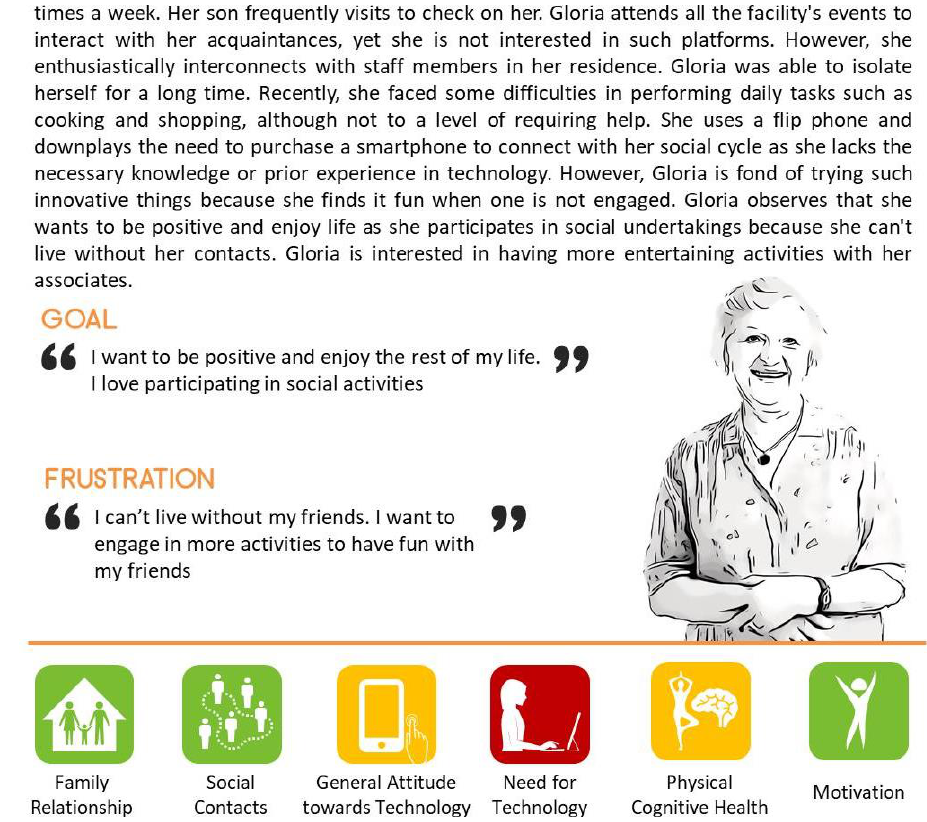
Figure 4. Case 4—Representative character to present social use of technology.